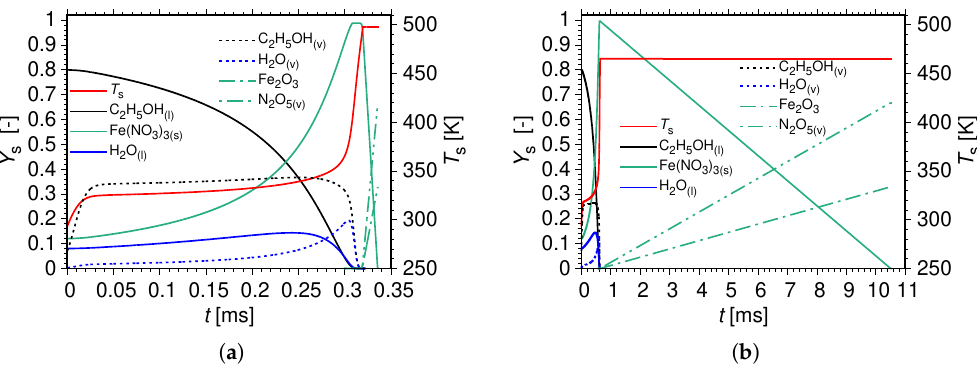
Figure 1. Species mass fractions and droplet surface temperatures versus time. Initial conditions: r d,0 = 5 µ m, T l,0 = 293.15 K, p = 1 bar, u 0 = 4 m/s, Y C ( b ) T = 800